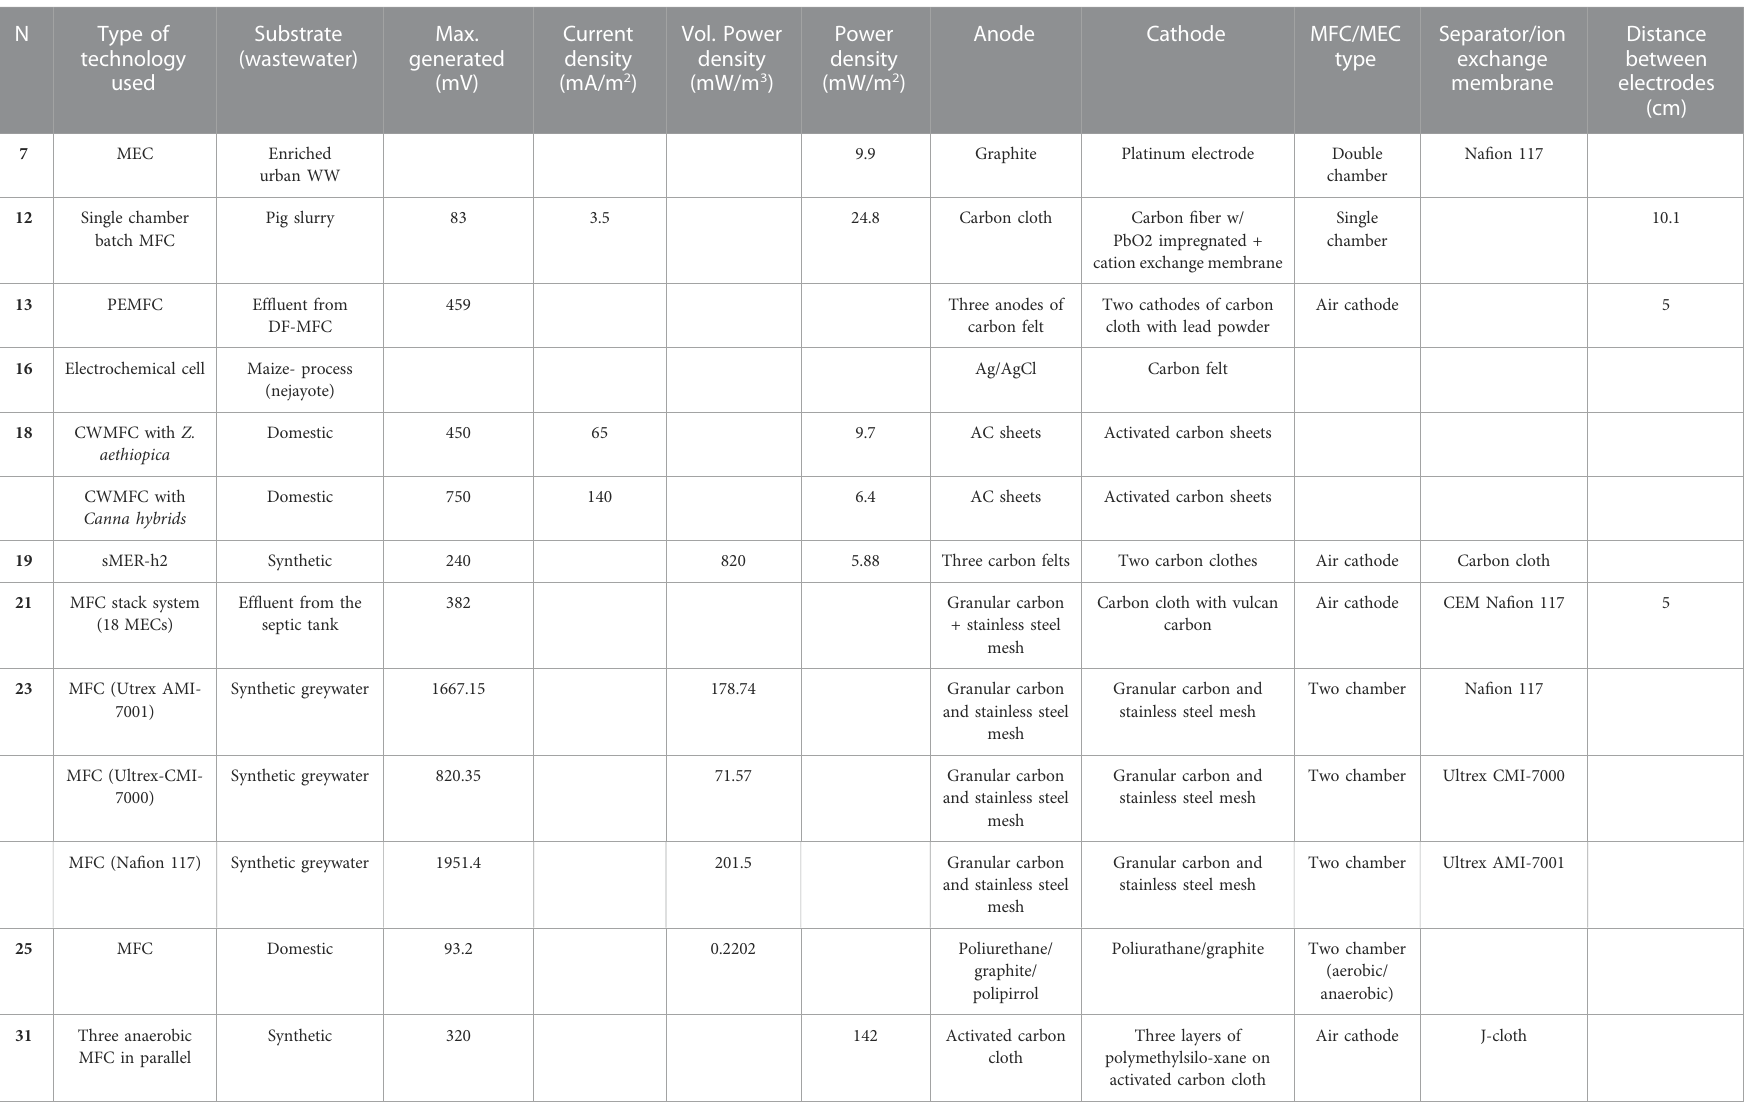
TABLE 7 Electricity production wastewater and basic